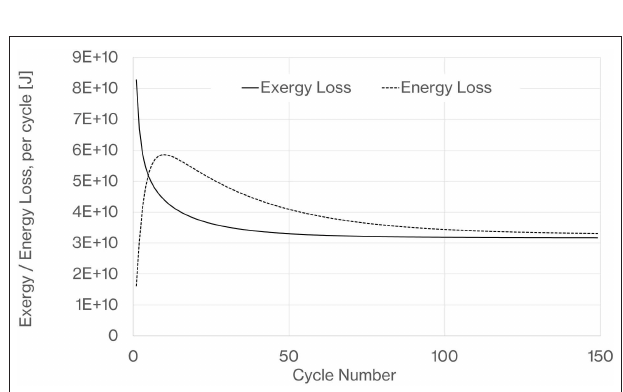
FIGURE 15 | Cold store temperature profiles ( z = 0 is bottom, z = 10m is top). (a) After initial charge, (b) after initial discharge, (c) after 100 charge cycles, (d) after 100 discharge cycles.